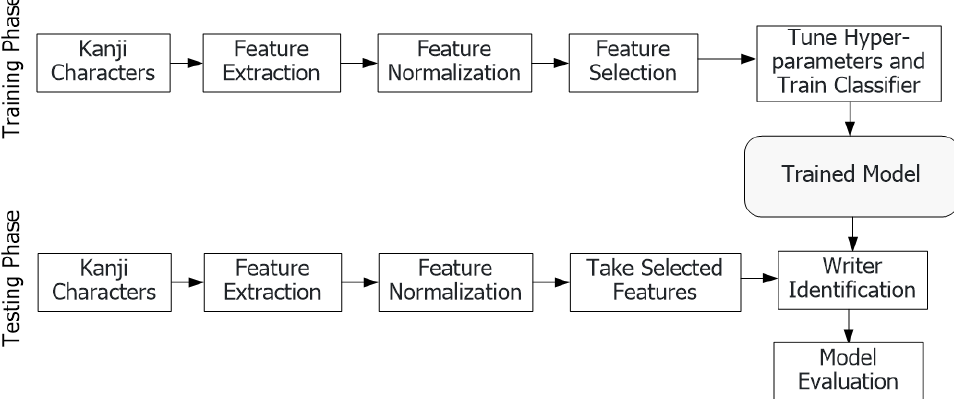
Figure 2. Block diagram of the proposed model for writer